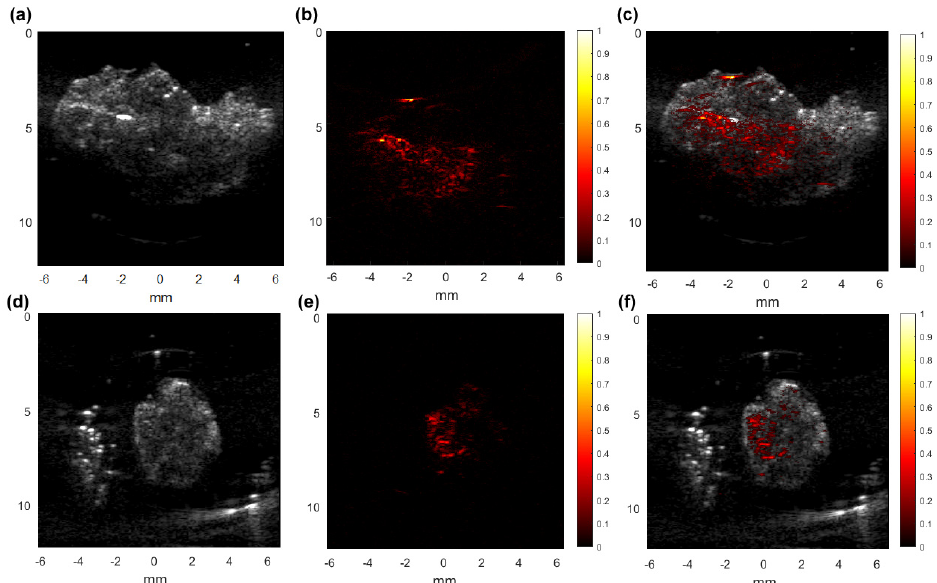
Figure 5. PA and US images of a cancerous mouse prostate (top line) vs. a normal mouse prostate (bottom line). ( a ) Gray–scale US image of the cancerous prostate. ( b ) Pseudo–color PA image at 630 nm obtained from the same imaging plane of ( a ). The dominant signals are from the F3–conjugated MB PAA NPs that specifically target cancer cells. ( c ) The PA image in ( b ) superimposed on the US image in ( a ). ( d ) Gray–scale US image of the normal prostate. ( e ) Pseudo–color PA image at 630 nm obtained from the same imaging plane of ( d ). ( f ) The PA image in ( e ) superimposed on the US image in ( d ).